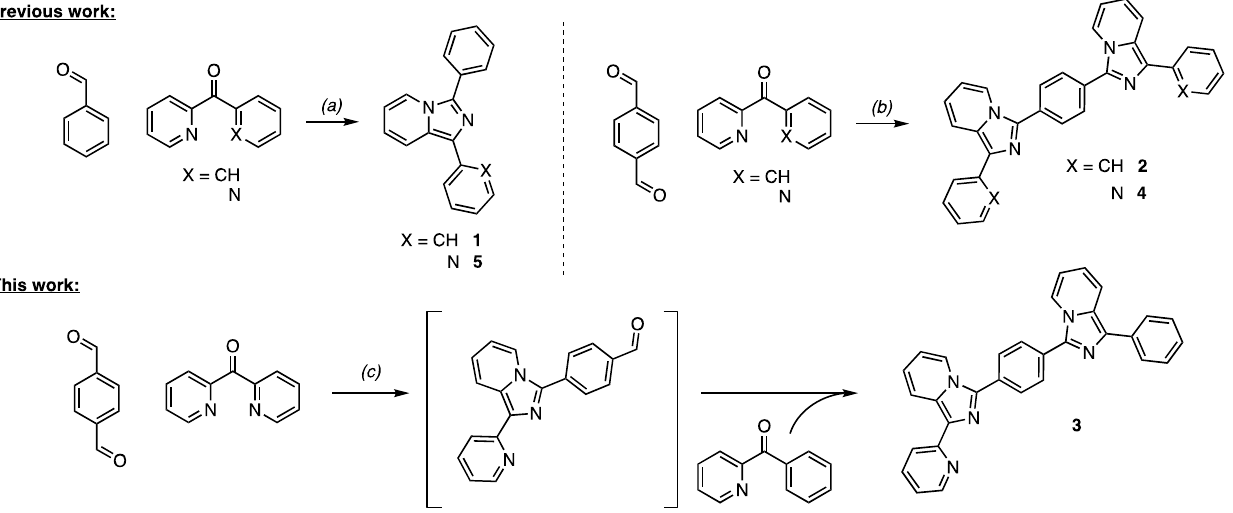
Figure 2. Synthetic approach toward the prepared compounds. ( a ) ammonium acetate, acetic acid, 110 °C, 5 h ( 1 : 78%, 5 : 80%); ( b ) ammonium acetate, acetic acid, 118 °C, 12 h ( 2 : 96%, 4 : 96%); ( c ) 1. ammonium acetate, acetic acid, 118 °C, 6 h; 2. (phenyl(pyridin-2-yl)methanone, 118 °C, 12 h (78%). 4 : 96%); ( c ) 1. ammonium acetate, acetic acid, 118 ◦ C, 6 h; 2.